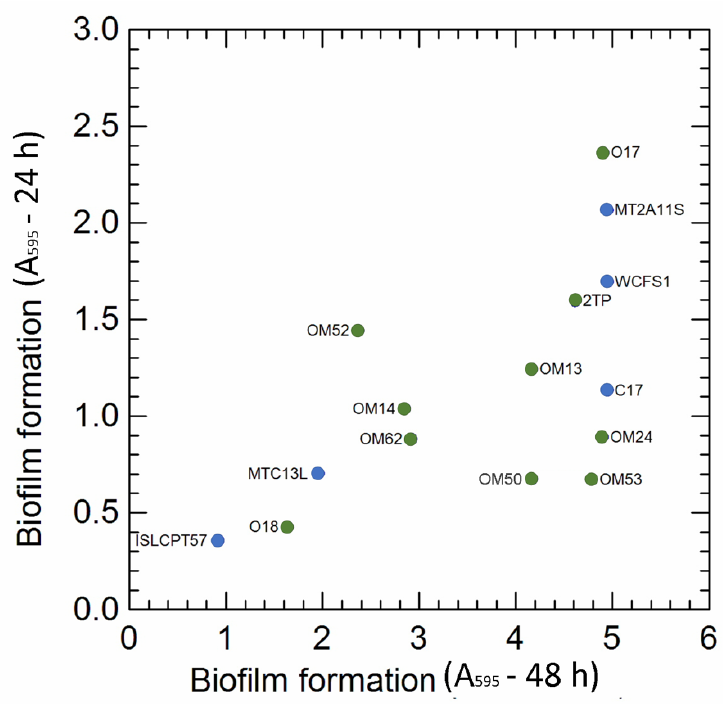
Figure 4. Biofilm formation in the 15 selected Lactiplantibacillus strains after 24 and 48 h incubation. Colour: green Lpb. pentosus strains (isolated from olive and brine); blue, Lpb. plantarum strains (isolated from other sources, e.g. , sourdoughs, cheese, human).